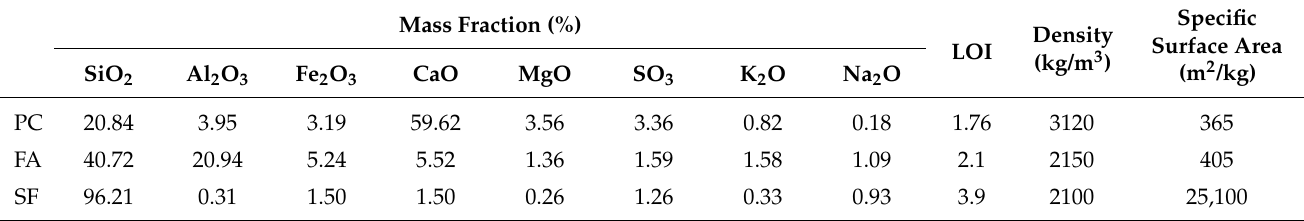
Figure 1. Particle size distributions. Table 1. Chemical compositions and physical properties of binder materials.